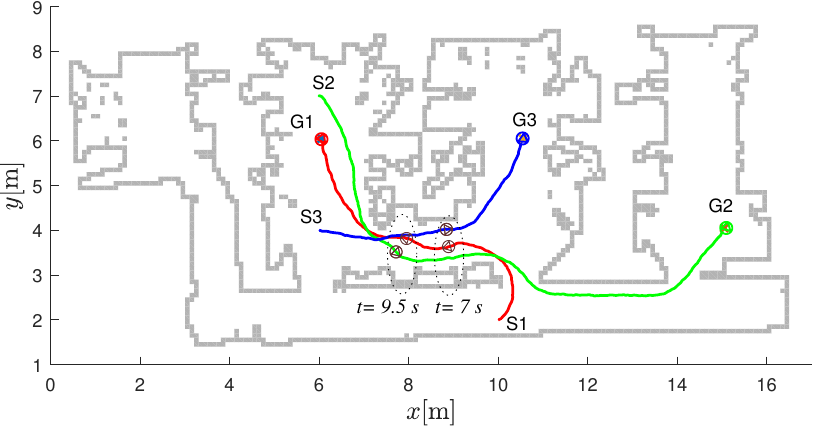
Figure 16. Robot paths in the laboratory layout. The start location of the i -th robot is denoted by S i and the destination locations by G i . Safe navigation during collision avoidance is represented by dark gray circles belonging to the robots passing simultaneously (the right pair of circles belongs to time t = 7 s and the left pair to time t = 9.5